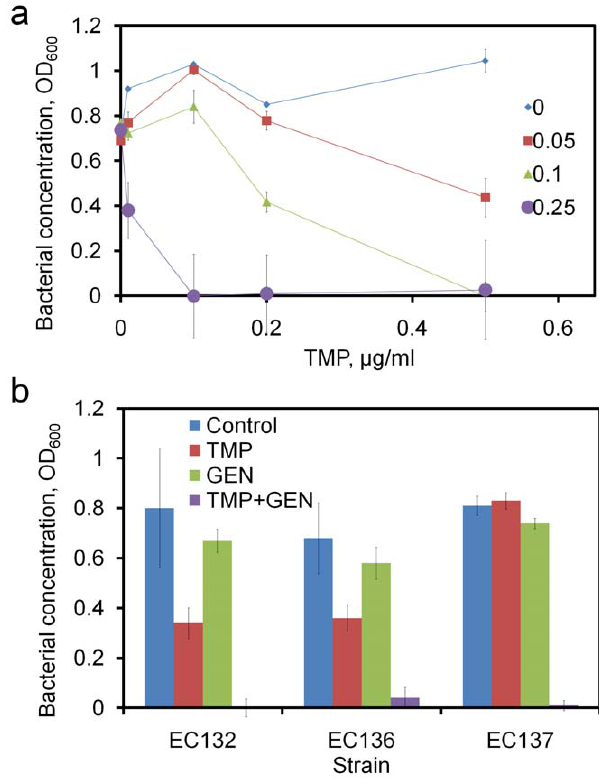
Figure 5. Synergistic activity of TMP and GEN. (a) In the sensitivity analysis of the TMP-GEN cocktails, the dose dependence of TMP on the bacterial growth with different concentration of GEN (in m g/ml) is determined. (b) The antimicrobial cocktail with TMP (0.25 m g/ml) and GEN (0.25 m g/ml) were tested for its individual and interaction effects. The values of EC 132 and EC 137 were not observable in the graph due to the low optical density.